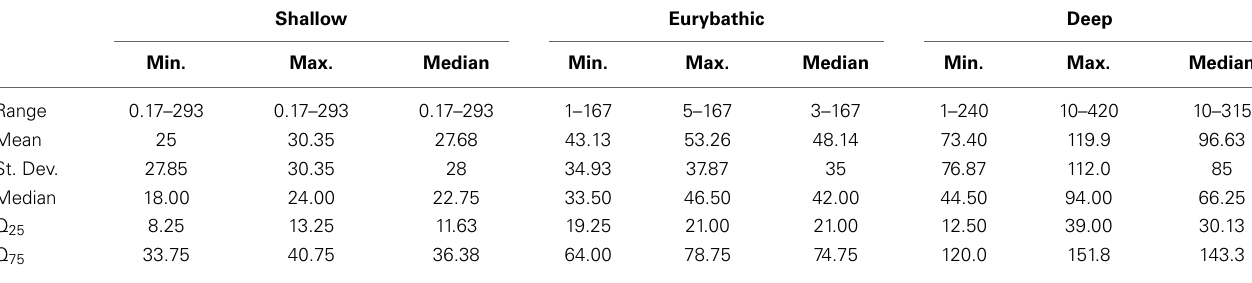
Table 2 | Descriptive statistics of the available minimum, maximum and median PLD values (days) for shallow ( N = 212); eurybathic ( N = 72) and deep species ( N = 20; the value of 660 days determined for Sclerasterias tanneri was not